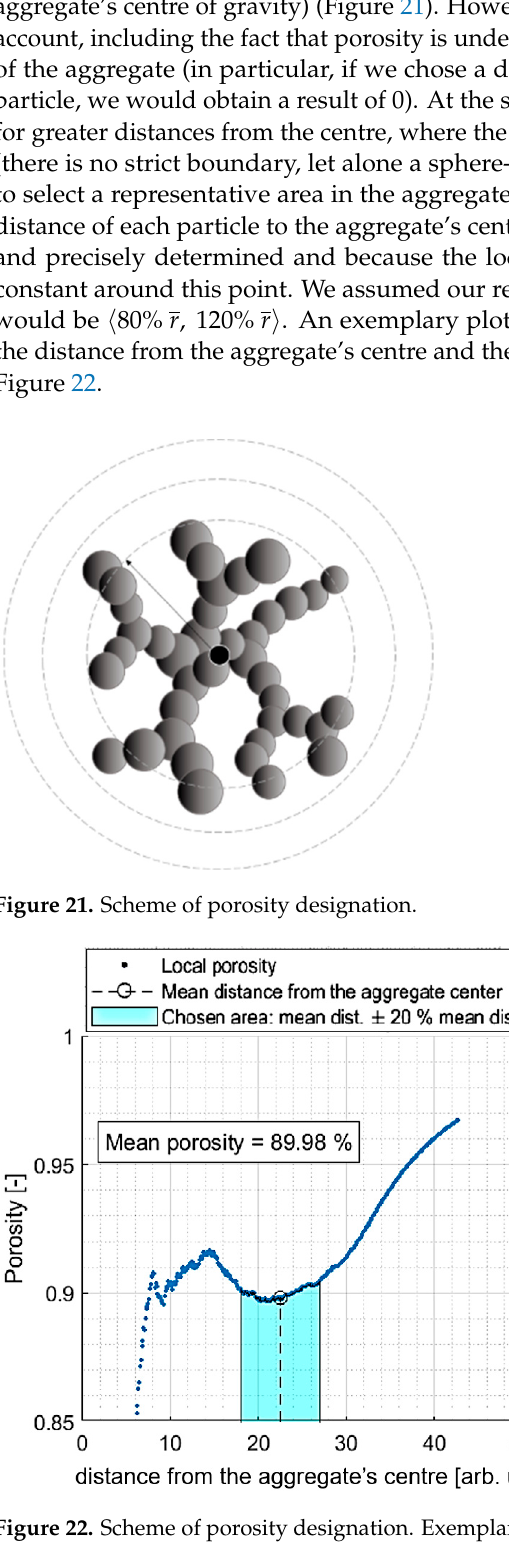
Figure 20. Impact of an aggregate threshold size on condensation kinetics curve.